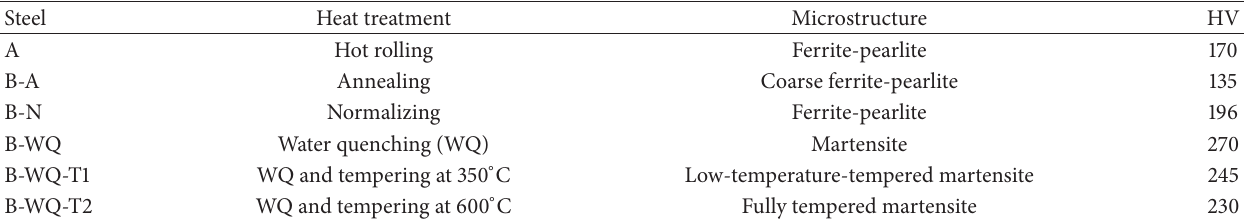
Figure 1: Microstructures of steels (Nital 2 etching). Table 2: Heat treatments and microstructure of the tested steels.